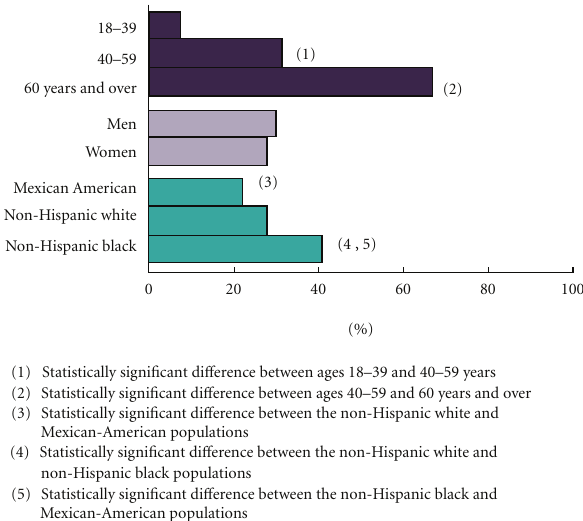
Figure 1: Age-specific and age-adjusted prevalence of hypertension in adults: United States,